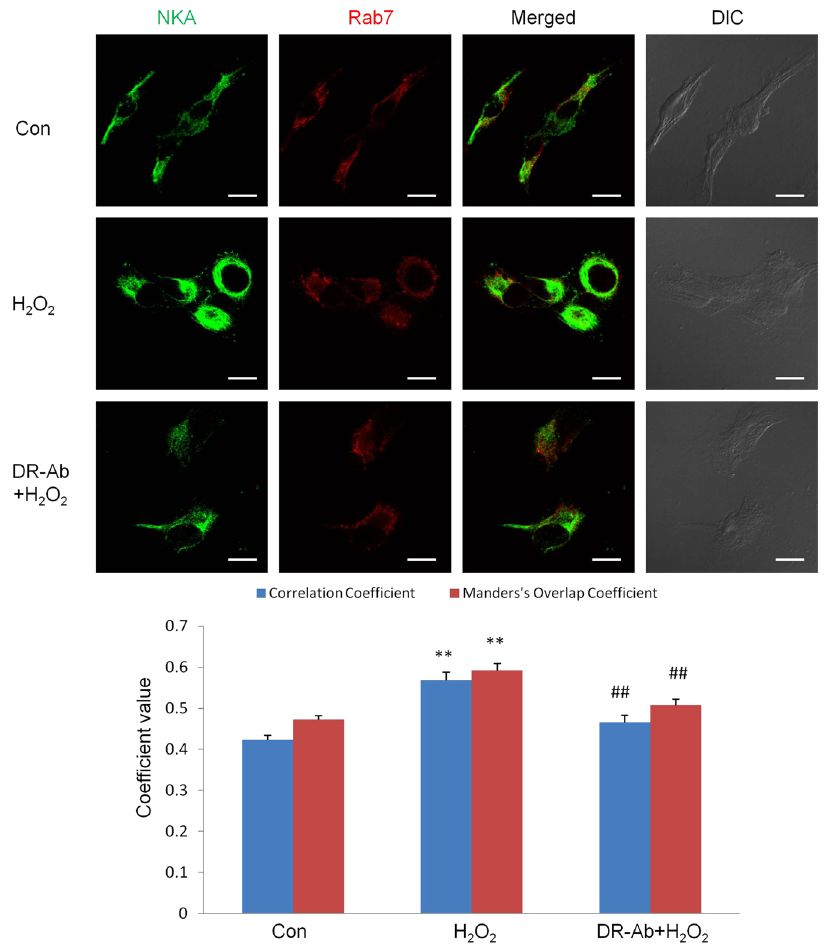
Figure 7. Immunofluorescence staining showing the endocytosis of NKA in AC16 cells. Representative immunofluorescence staining and co-localization analysis showing the increased co-localization of NKA (Green) with late endosome marker, rab7 (Red) in AC16 cells treated with 100 µ M H 2 O 2 for 1 hr. n = 17. Scale bar, 10 μ